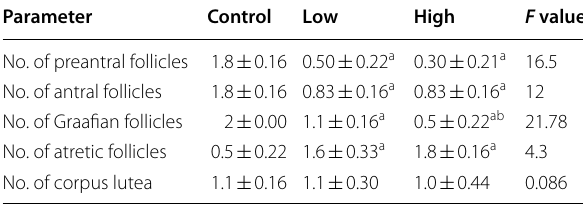
The data are expressed as mean a P < 0.05 as compared with control b P < 0.05 between treated groups